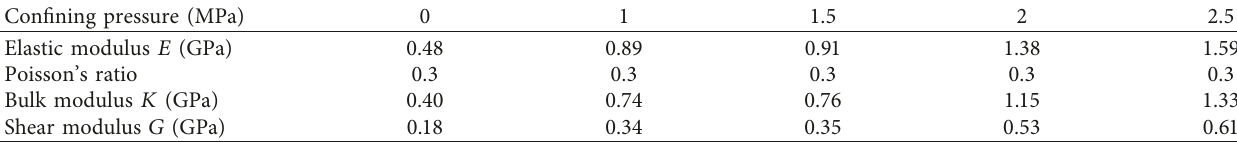
Table 3: Bulk modulus and shear modulus under different confining